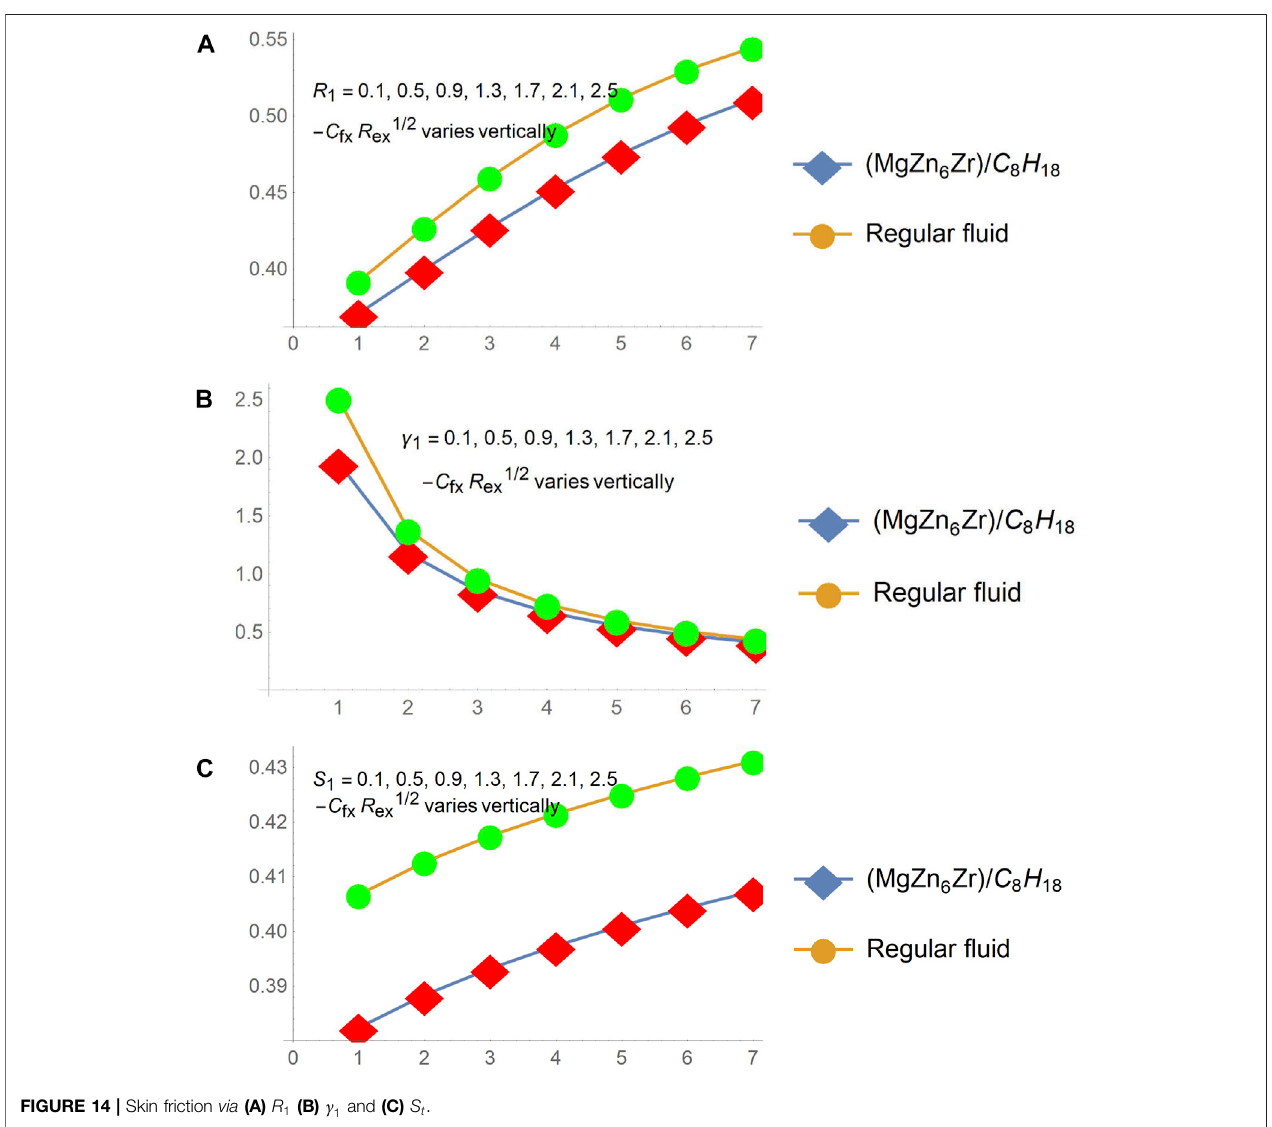
substitutions, the higher order model should be transformed into fi rst order IVP. (cid:129) The BCs are adjusted accordingly, and the